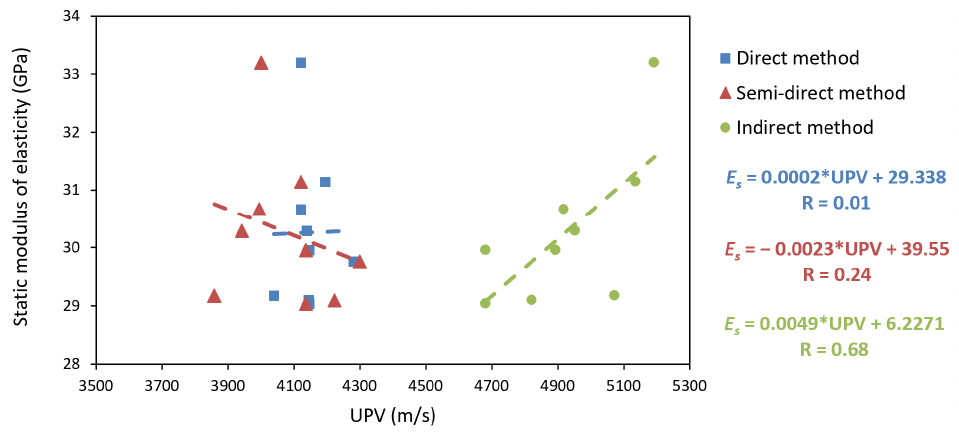
Figure 15. Correlation between ultrasonic pulse velocity and the static modulus of